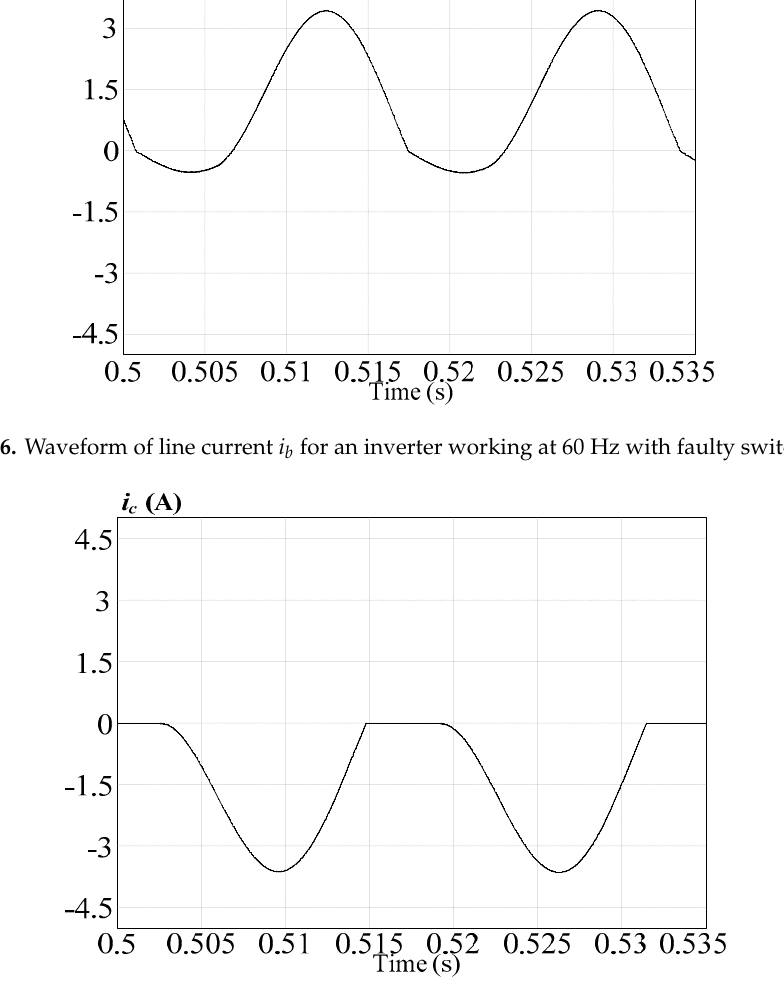
Figure 7. Waveform of line current i c for an inverter working at 60 Hz with faulty switch Sc 2 + . It is clear from the above analysis that anomalies can be observed in current frequency spectra when an inverter is faulty, as in the case of an inverter working at 60 Hz with faulty switch S c2 + , where the resultant current frequency spectrum is given as shown in Figure 8. When compared with the